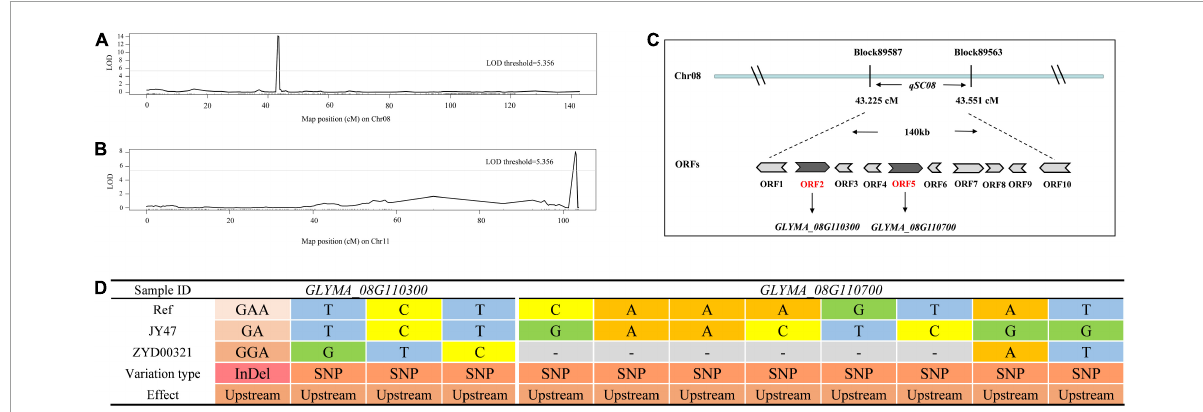
FIGURE3 Fine mapping of two QTLs. (A) Mapping of QTLs for seed coat color on Chr08. The curves indicate the physical position of markers against the LOD score of the QTLs detected on Chr08. (B) Mapping of the QTLs for seed coat color on Chr11. The curves indicate the physical position of the markers against the LOD score of the QTLs detected on Chr11. (C) Distribution of tightly linked markers and plausible candidate genes for seed coat color on qSC08 in soybean. (D) SNP/InDels variants based on re-sequencing data from both parents of GLYMA_08G110300 and GLYMA_08G110700